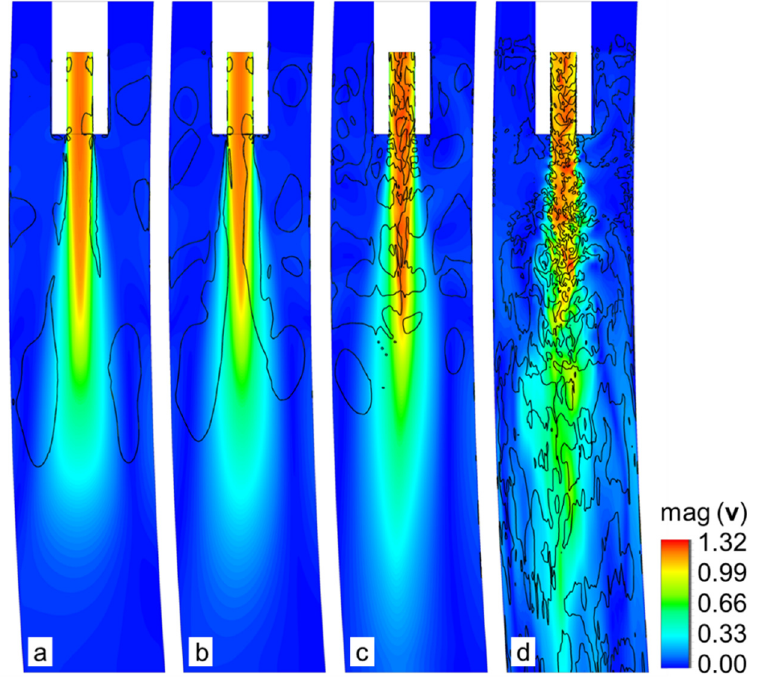
Figure 7. Turbulent structures represented as iso-values of λ 2 = − 0.15 s − 2 on top of the velocity magnitude contours on the x-y plane at z = 0 m for A1 ( a ), A2 ( b ), A3 ( c ), and A4 ( d ).